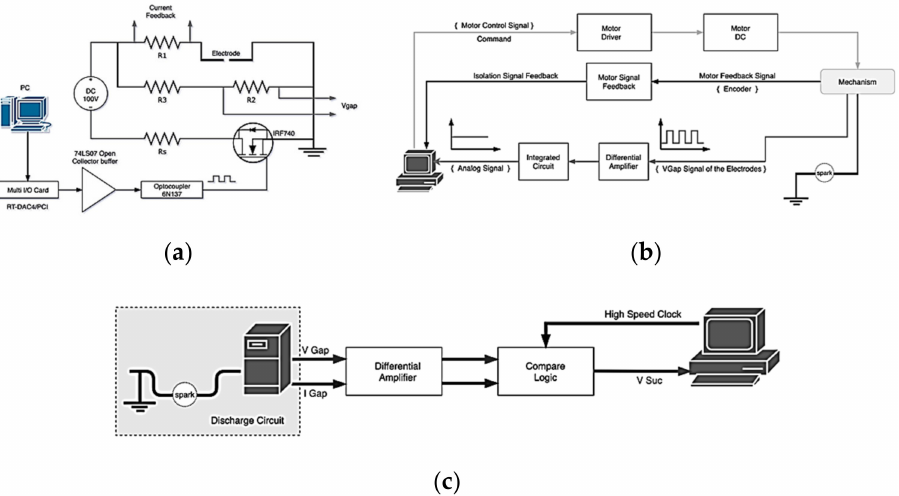
Figure 3. Circuit blocks of micro-EDM. ( a ) Discharge circuit, ( b ) motor control and signal feedback circuit, and ( c ) logic determination